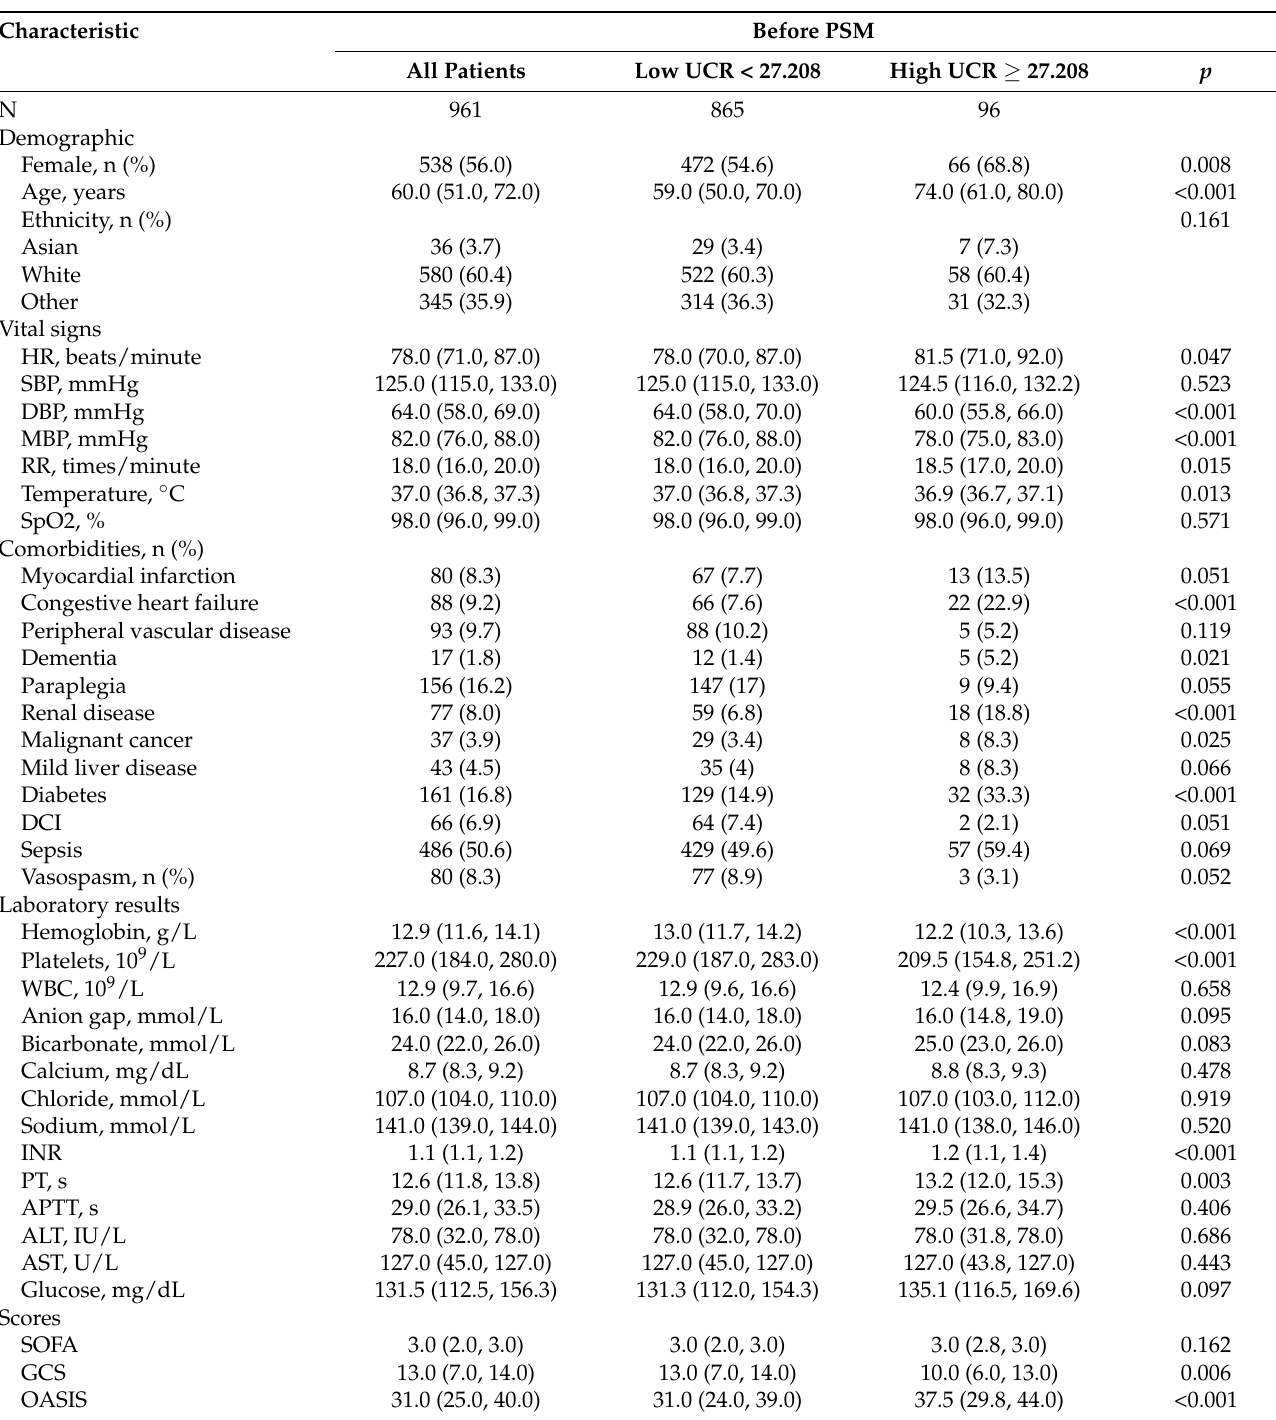
Table 2. The clinical characteristics of non-traumatic subarachnoid hemorrhage patients before